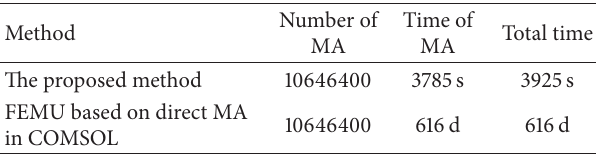
Table 7: Comparison of computational